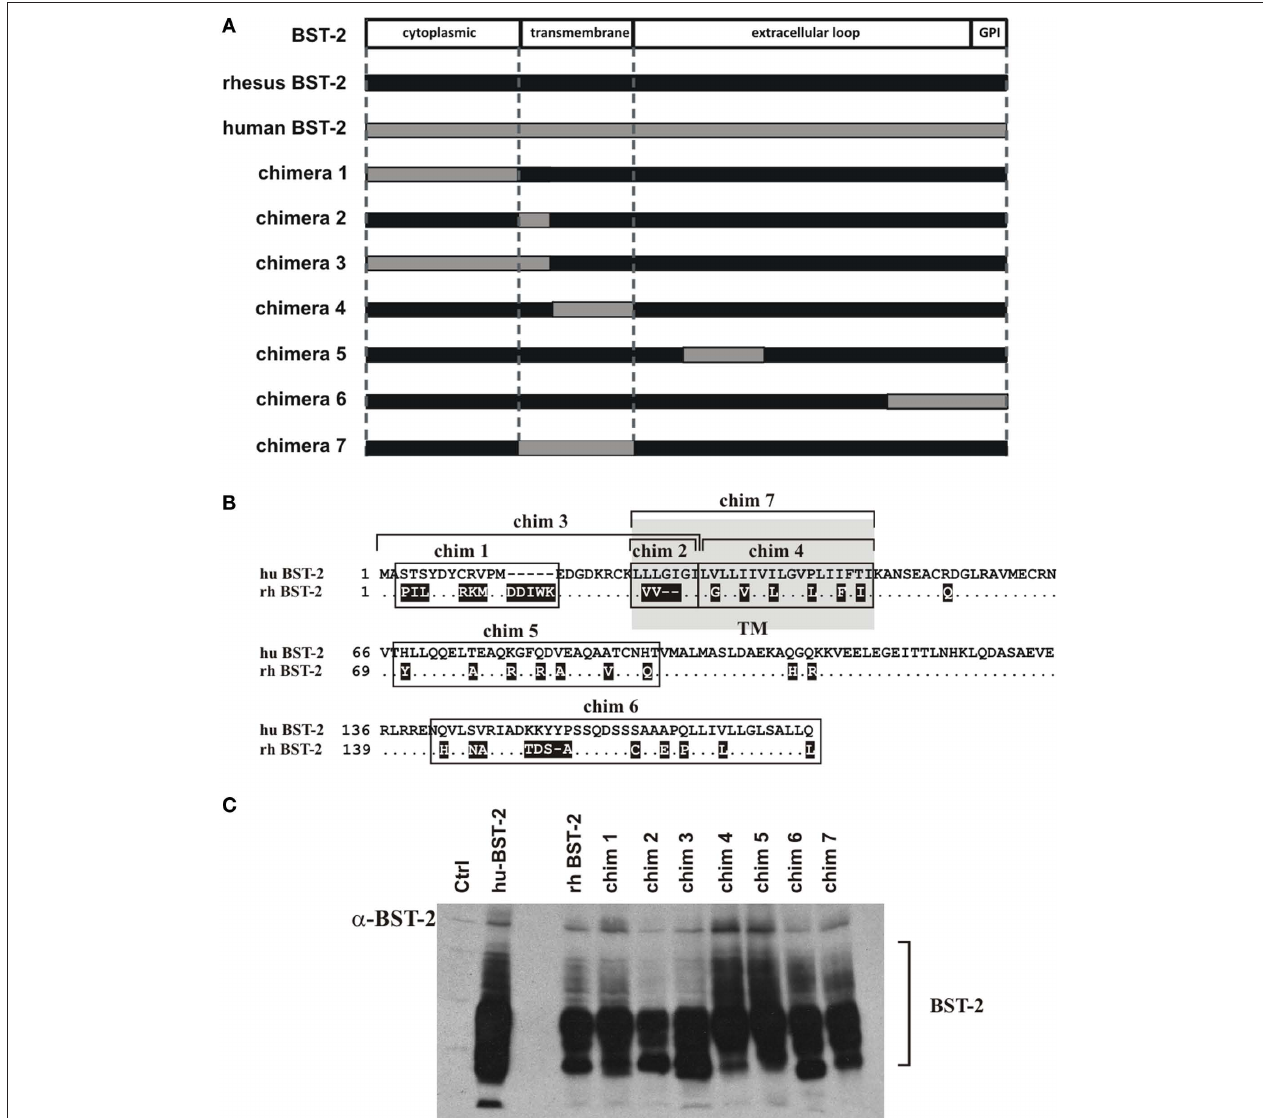
FIgure 3 | Construction and analysis of rhesus–human BST-2 chimeras. (A) Schematic diagram of BST-2 chimeras. The black bar represents rhesus BST-2 and the gray bar indicates human BST-2. Regions from human BST-2 inserted into the rhesus BST-2 backbone are indicated as gray areas. Boundaries of cytoplasmic domain, TM domain, and ectodomain are marked by dashed lines. (B) Alignment of human and rhesus BST-2. Shown is an alignment of human BST-2 against rhesus BST-2 variant #4. Sequence identities are indicated as dots. Deletions are marked as dashes. Amino acid changes in rhesus BST-2 relative to human BST-2 are